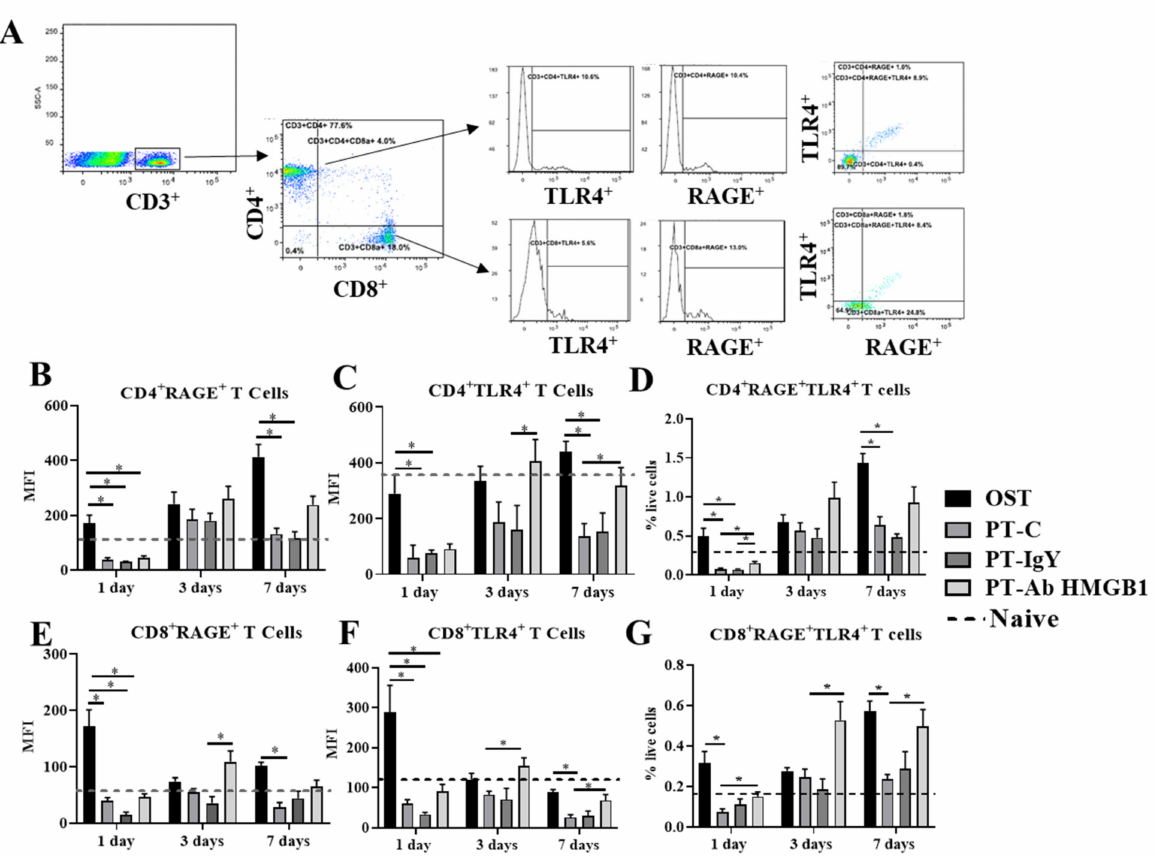
Figure 5. ( A ) Flow cytometry gating scheme to quantify CD4 + and CD8 + T cells expressing RAGE and TLR4 surface receptors in blood at 1, 3 and 7 days post-trauma (dpt) in osteotomy (OST; n = 10), polytrauma (PT-C; n = 10), polytrauma + IgY (PT-IgY; n = 5 for 1 and 3 dpt; n = 4 for 7 dpt) and polytrauma + anti-HMGB1 antibody (PT-Ab HMGB1; n = 10) rats; ( B ) mean fluorescence intensity (MFI) of CD4 + RAGE + T cells; ( C ) MFI of CD4 + TLR4 + T cells; ( D ) percent (%) of CD4 + RAGE + TLR4 + T cells in blood; ( E ) MFI of CD8 + RAGE + T cells; ( F ) MFI of CD8 + TLR4 + T cells; ( G ) % of CD8 + RAGE+TLR4+ T cells in blood. Naïve uninjured rats were used as baseline controls ( n = 5). The dotted line is an average of cell counts from naïve rats. * p < 0.05 comparing OST, PT-C, PT-IgY and PT-Ab HMGB1 cohorts. The bar graphs represent mean, whereas error bars represent